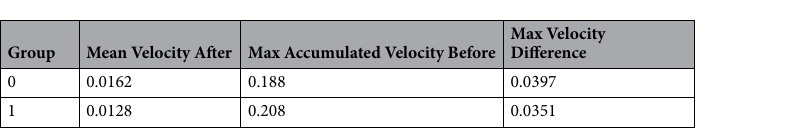
Table 2. Pupil-size statistics for significant custom features.